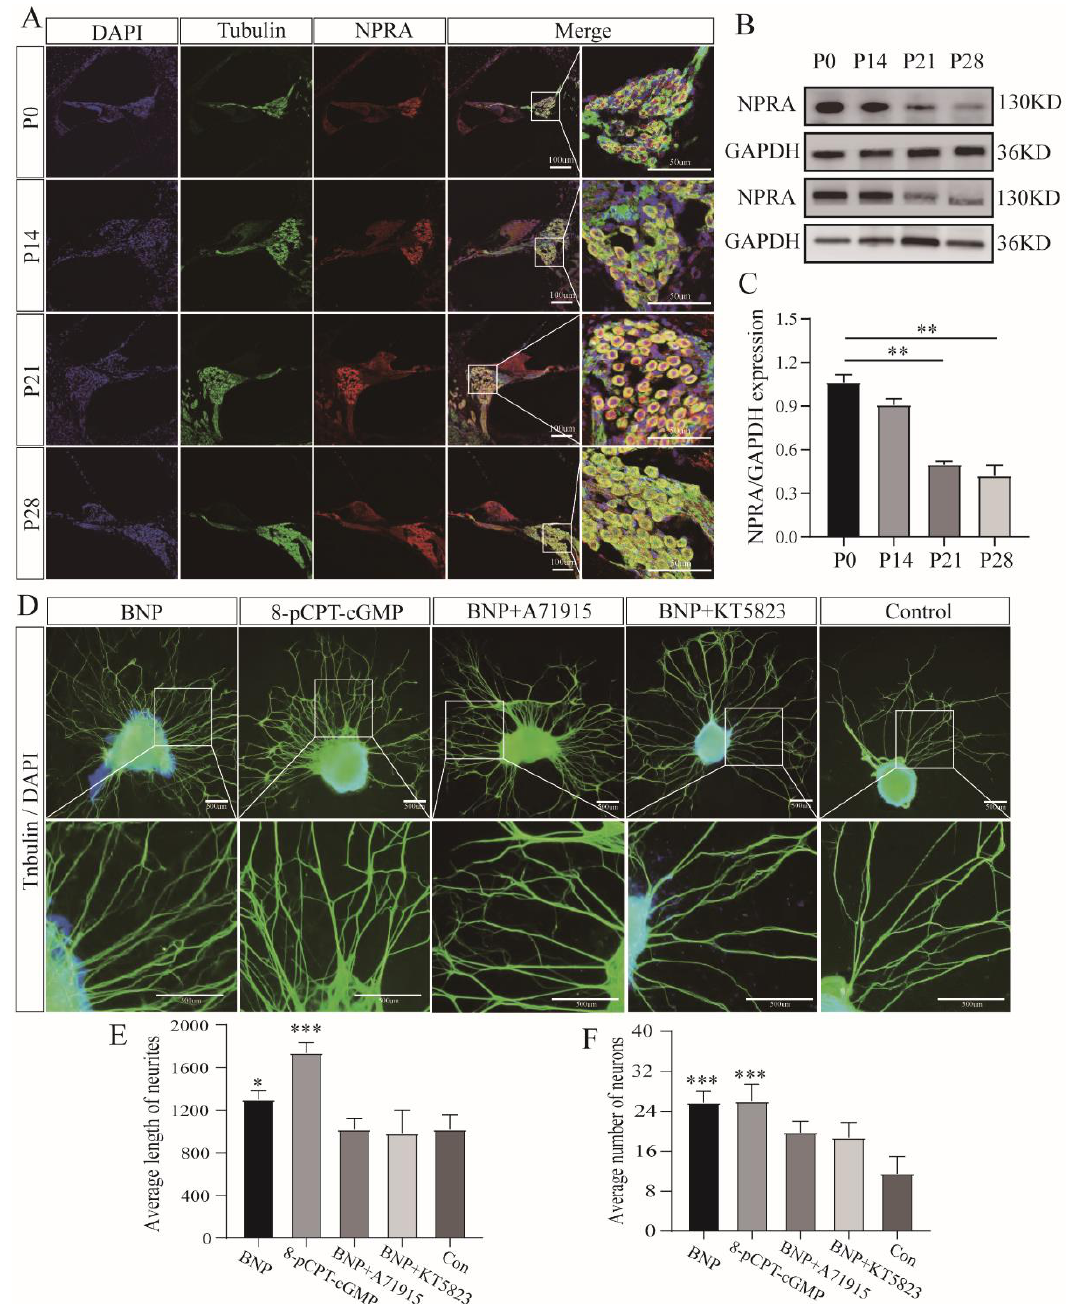
Figure 3. BNP promotes neurite growth in spiral ganglion explants through the NPRA-cGMP-PKG Signaling pathway. ( A ) Expression and localization of NPRA in the cochlea. NPRA is expressed in rat spiral ganglion neurons and remains unchanged throughout development. ( B ) NPRA protein expression at different ages detected by Western blot, using GAPDH as the endogenous housekeeping control gene. ( C ) Histograms for Western blot results, fold change relative to P0. ( D ) SG explants were maintained in culture medium alone or medium supplemented with 20 ng/mL 1 µM BNP, 1 µM 8-pCPT-cGMP, 1 µM BNP plus 1 µM A71915, 1 µM BNP plus 1 µM KT5823 for 5 days. SG plants were double-labeled with TuJ1 antibody (green) and Hoechst (blue). Scale bar: 500 μm. ( E ) The average neurite growth length was quantified and compared under different conditions. ( F ) The average number of neurites was compared among five groups. All of the data are presented as the mean ± SD of three independent experiments. *, p < 0.05, **, p < 0.01, ***, p < 0.001 compared with the